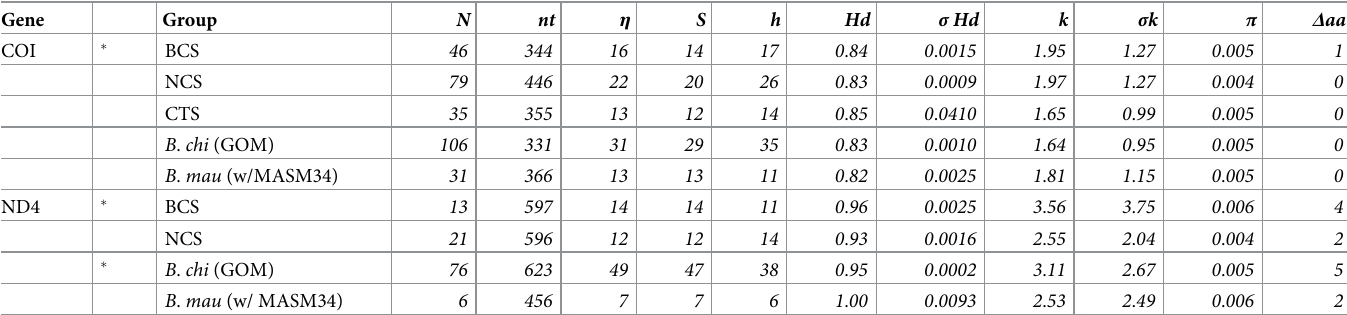
Table 2. Genetic diversity within different populations of B . childressi and B . mauritanicus at COI and ND4 mitochondrial genes. Gene